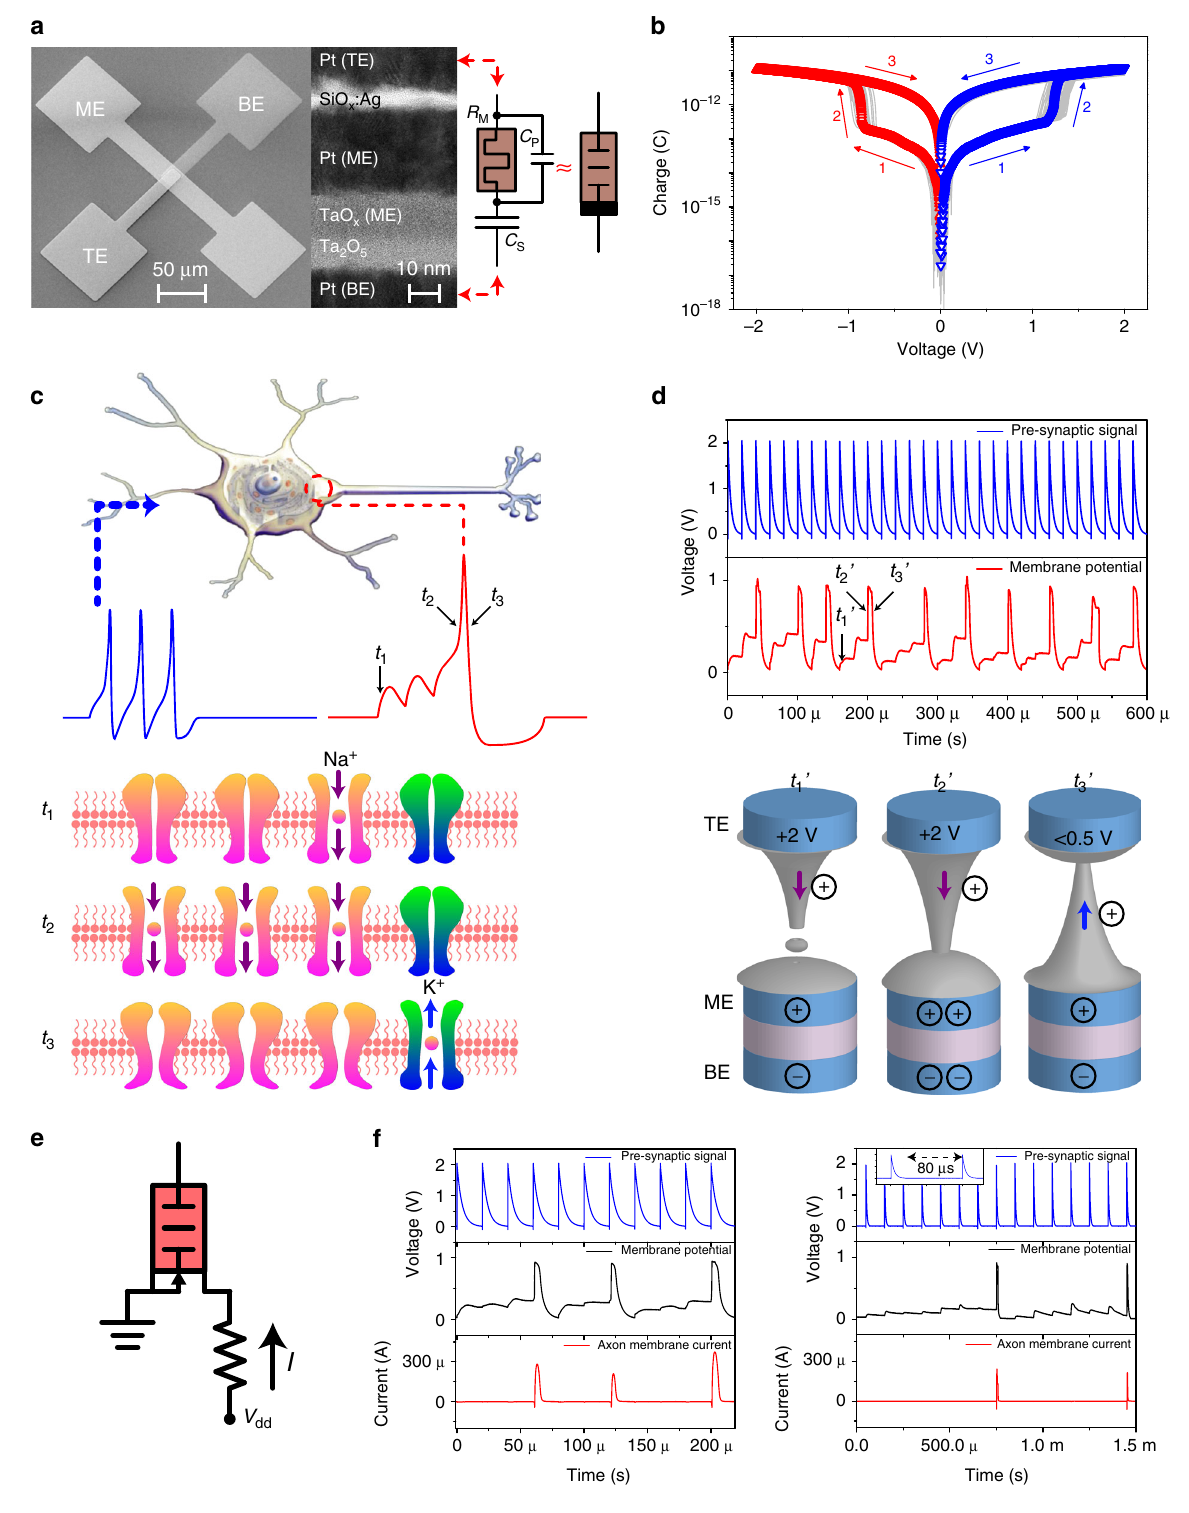
expected behavior illustrated for a neuron at t 1 in Fig. 1c. At time t 2 ′ , the diffusive memristor was switched ON by the pre-synaptic spike to fully charge the capacitor, which replicated the upswing of the membrane potential due to the opening of all sodium ion channels at t 2 of Fig. 1c. At time t 3 ′ , the pre-synaptic input was low. The memristor was fi rst switched OFF and then switched ON again with opposite bias by the charged capacitor (see